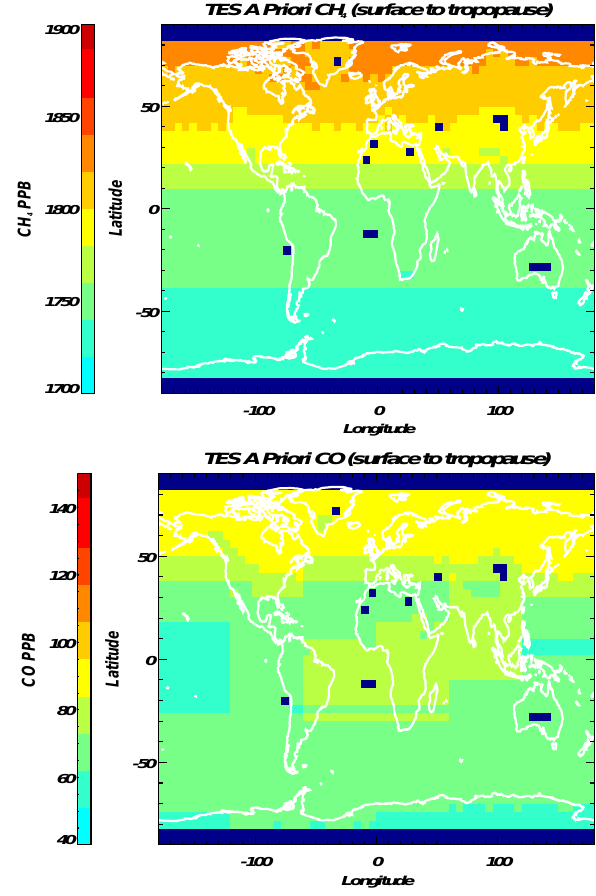
Fig. 8. (a) The TES CH 4 a priori, averaged over all pressure levels in the TES forward model in the troposphere. (b) Same as in (a) but for